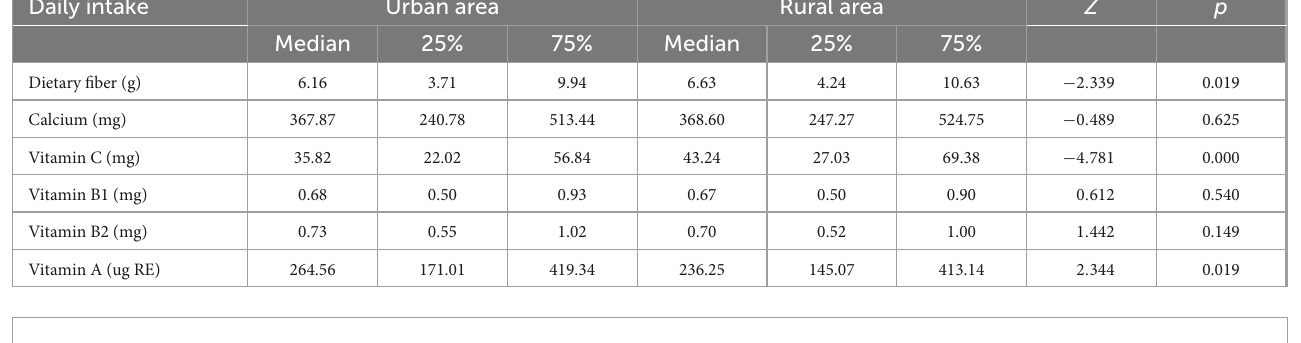
TABLE 2 Dietary fiber, calcium, vitamin B1, vitamin C, vitamin A, vitamin B2 intake of urban and rural children and adolescents. Daily intake Urban area Rural area